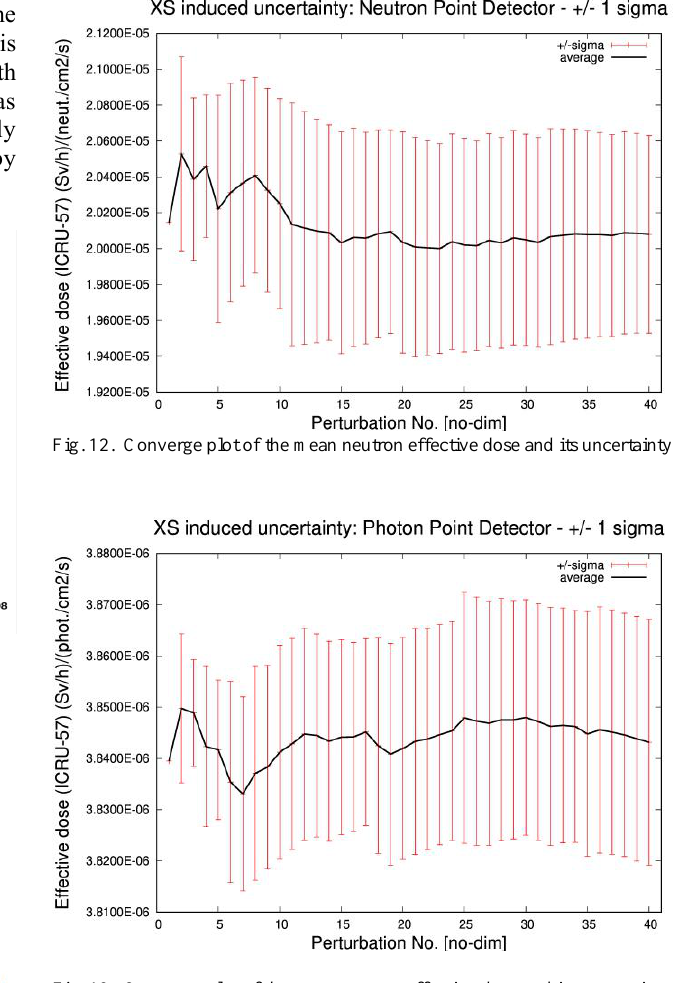
Fig. 13. Converge plot of the mean gamma effective dose and its